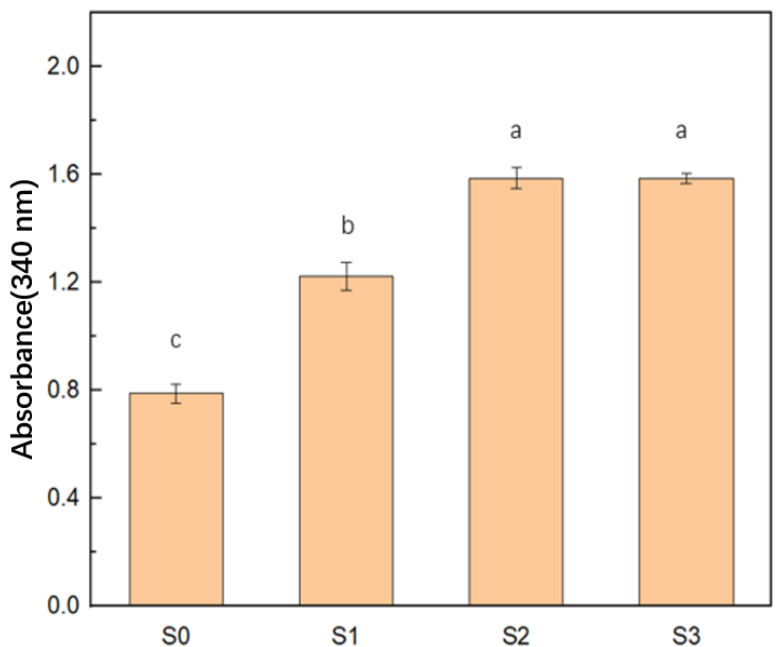
Figure 2. Turbidity value of EPI isolate cross-linked under different enzyme concentrations (0 u/g, 10 u/g, 20 u/g, 40 u/g). Different letters represent a significant difference at p < 0.05.